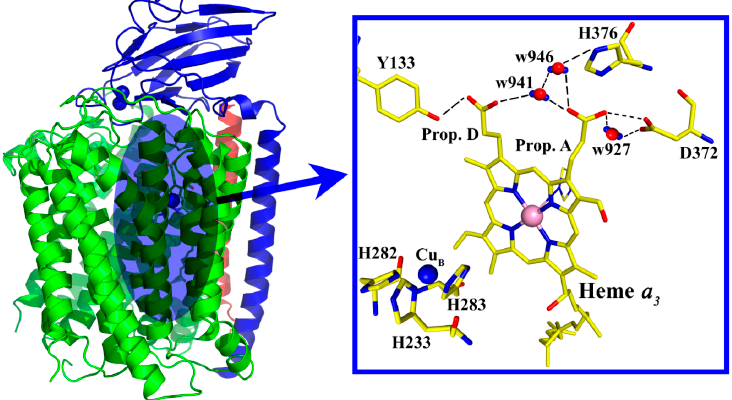
Figure 6. The binuclear heme a 3 -Cu B center and region of the heme a 3 propionates of ba 3 oxidoreductase from Thermus thermophilus illustrating the residues of interest [6]. Red, yellow and blue colors represent the oxygen, carbon and nitrogen atoms, respectively. The blue sphere represents the Cu B atom. In w941, w946 and w927 the red and blue colors represent the oxygen and hydrogen atoms, respectively. The highlighted water molecules are conserved in heme-copper oxidases [18].